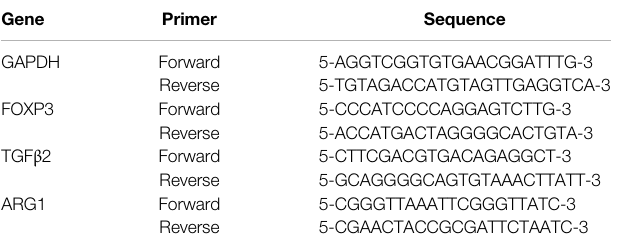
TABLE 1 | The details of Primer sequences used for RT-qPCR. Gene Primer Sequence